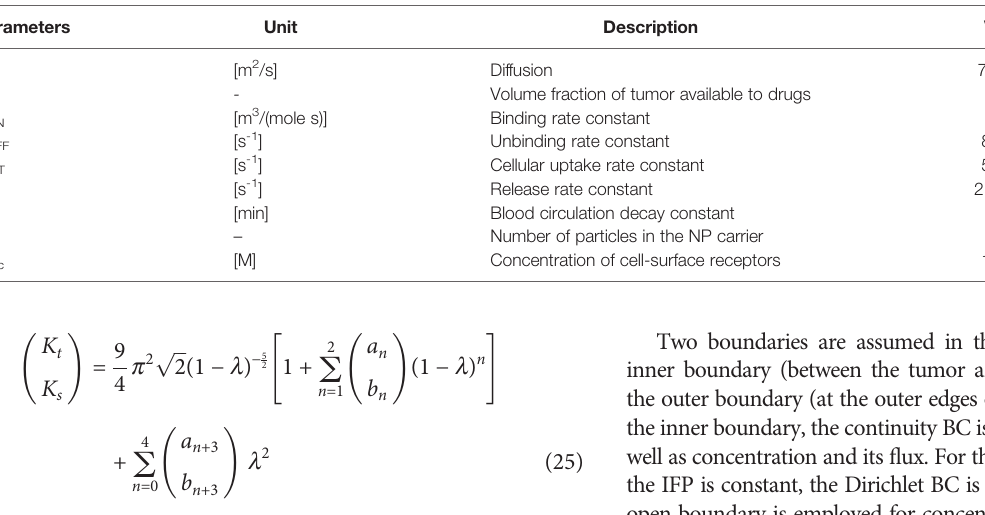
TABLE 4 | Parameters of baseline state for NP drug delivery for 20 nm particles and 200 nm VWP size.